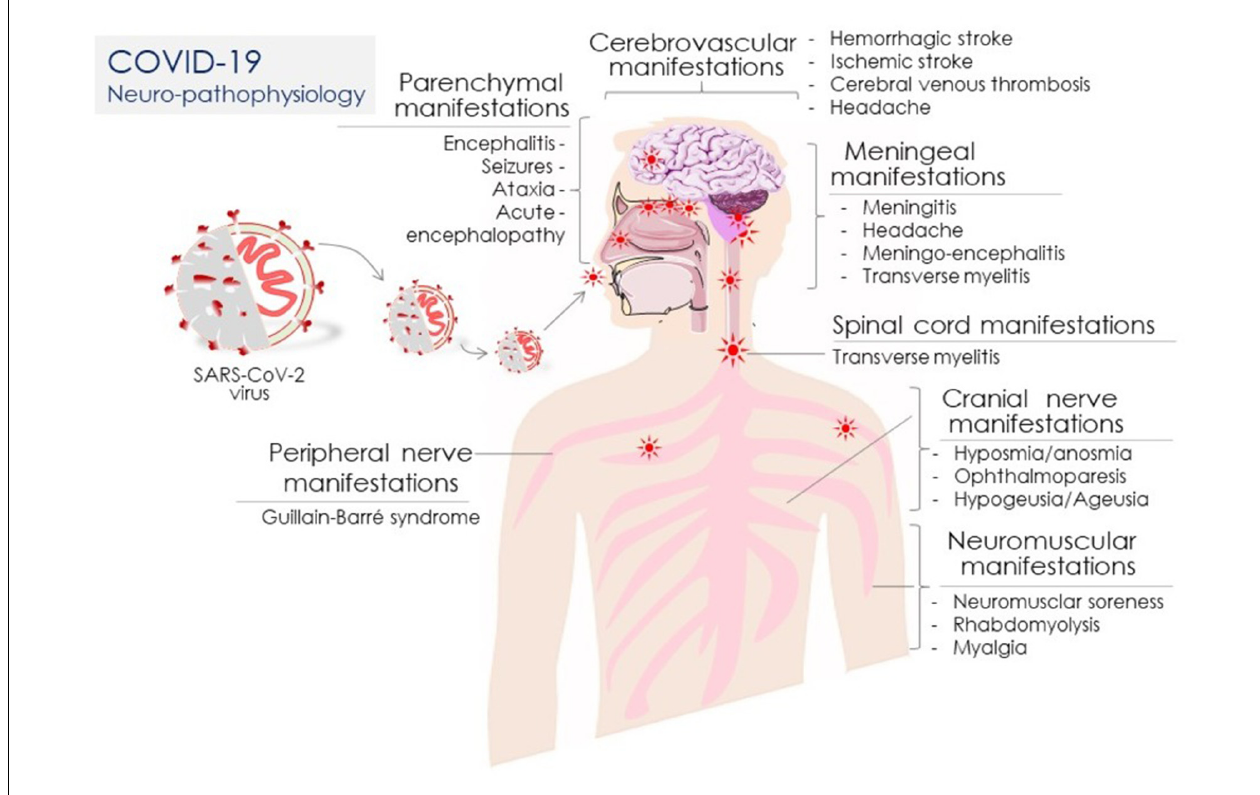
FIGURE 1 | Coronavirus disease 2019 (COVID-19) neuro-pathophysiology: COVID-19 clinical manifestations associated with diverse neuronal systems/organs including the peripheral nerve, parenchymal, cerebrovascular, meningeal, spinal cord, neuromuscular, and cranial nerve in SARS-CoV-2-infected